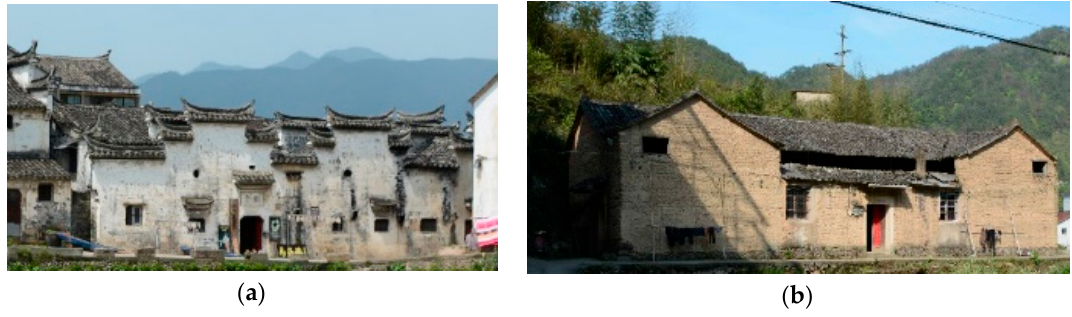
Figure 8. Exterior facades in ( a ) Heyang and ( b ) Danzhi.